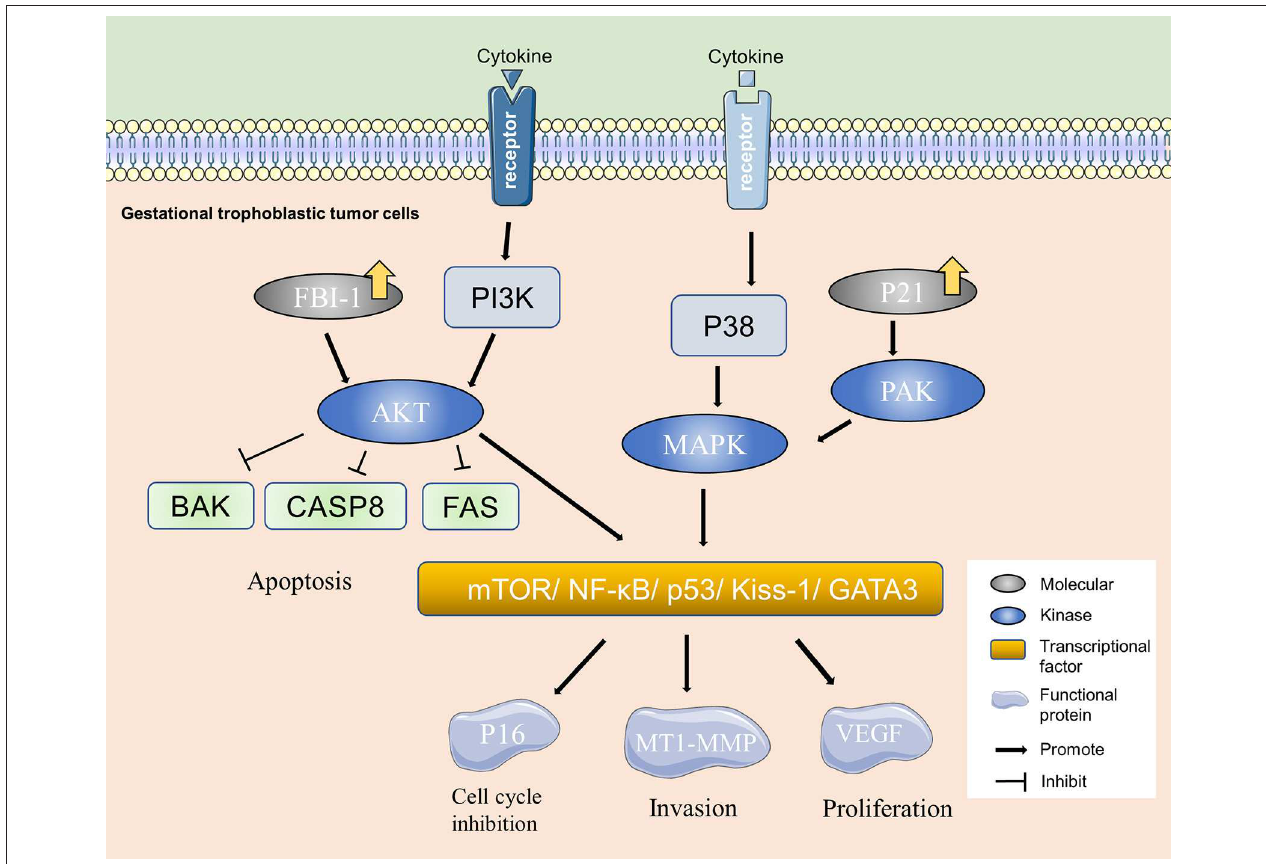
FIGURE 2 | Molecular mechanism of PSTT. PI3K/AKT and MAPK are important molecular pathways in PSTT. Over-expression of molecules, such as FBI-1 and P21 can activate kinases, such as PAK and AKT in gestational trophoblastic tumor cells and consequently cause changes in the adhesion-associated and cell cycle regulation proteins, resulting in alterations of biological behaviors including invasion and proliferation of